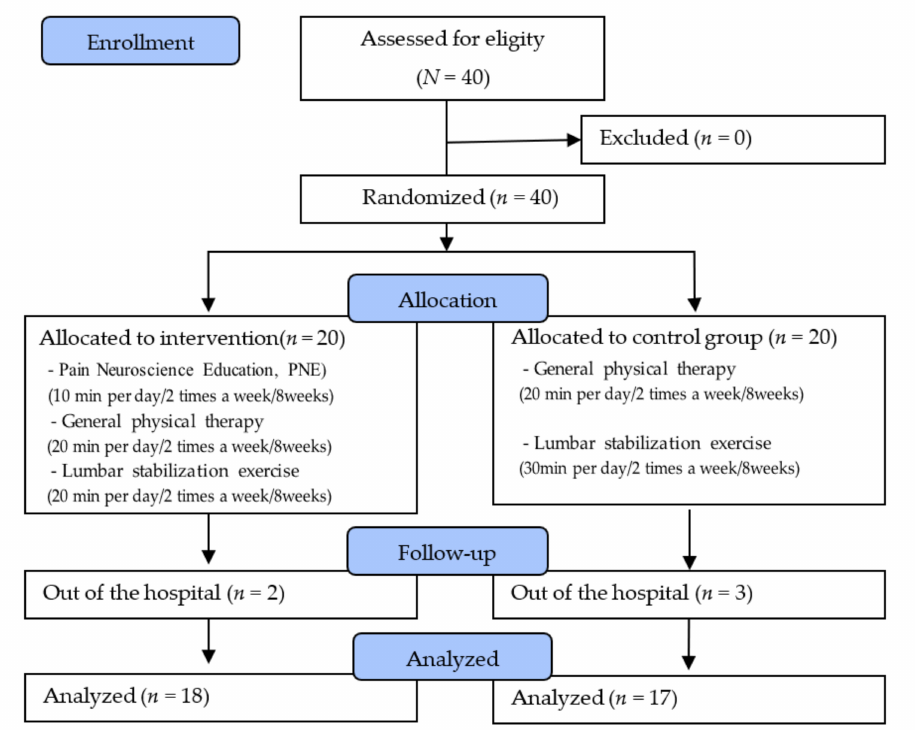
Figure 1. Flow diagram of total experimental procedure.